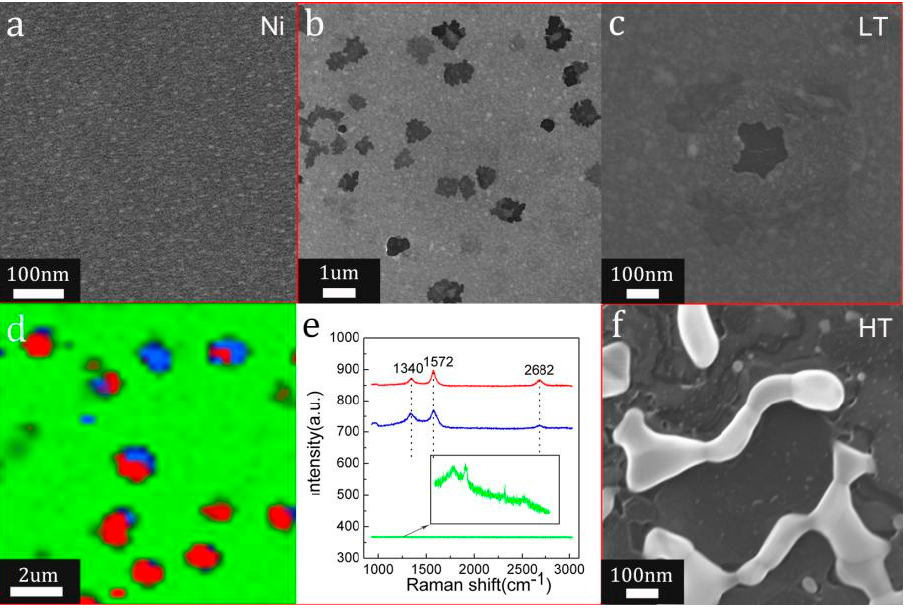
Figure 5. ( a ) SEM image of Si wafer coated with C and Ni layers before quenching; ( b , c ) the corre ‐ sponding SEM and HR ‐ SEM images after quenching with a pulse current of 6 A and a pulse width of 2 s; ( d ) Raman mapping of graphene; ( e ) Raman spectra of the red areas (red line), blue areas (blue line), green areas (green line) in ( d ); ( f ) HR ‐ SEM image after quenching with a pulse current (blue line), green areas (green line) in ( d ); ( f ) HR-SEM image after quenching with a pulse current of of 10 A and a pulse width of 2 s. 10 A and a pulse width of 2